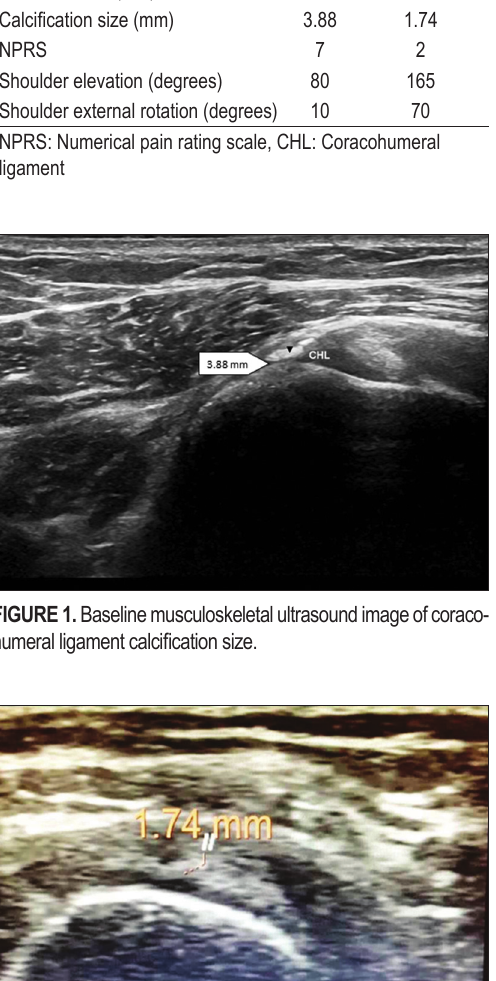
TABLE 1. Changes in outcomes following positional CHL stretching